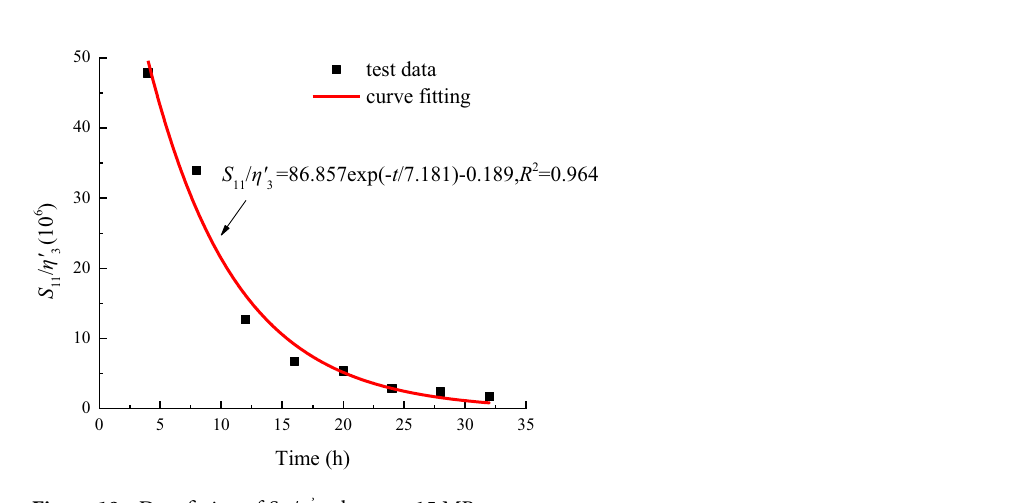
Figure 19. Data fitting of S 11 / η ’ 3 when σ 3 = 15